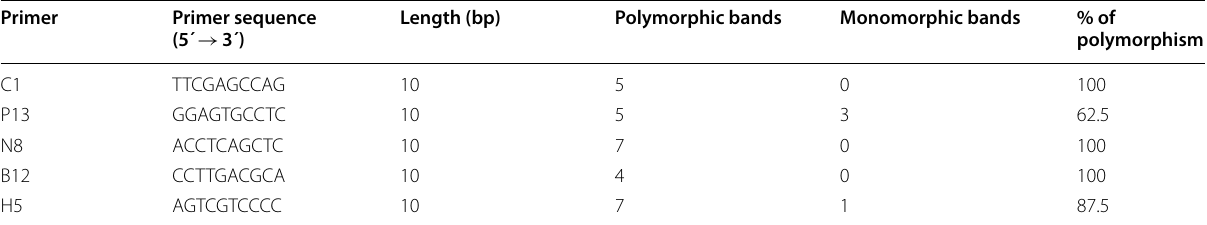
Table 3 RAPD primers used to evaluate genotoxicity in Eobania vermiculata snails after different duration of exposure to chitosan Primer Primer sequence